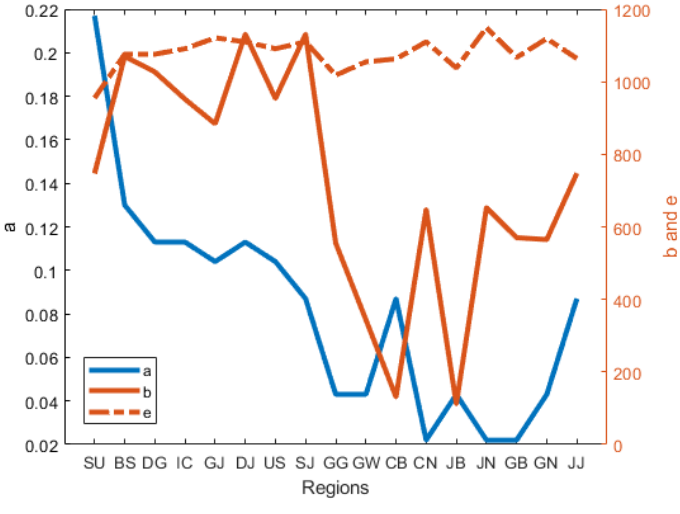
Figure 3. Parameters for case study